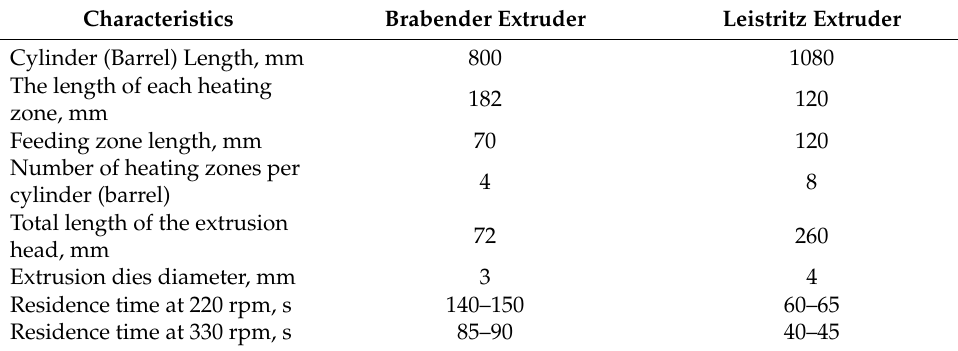
Table 1. Technical characteristics of Brabender and Leistritz